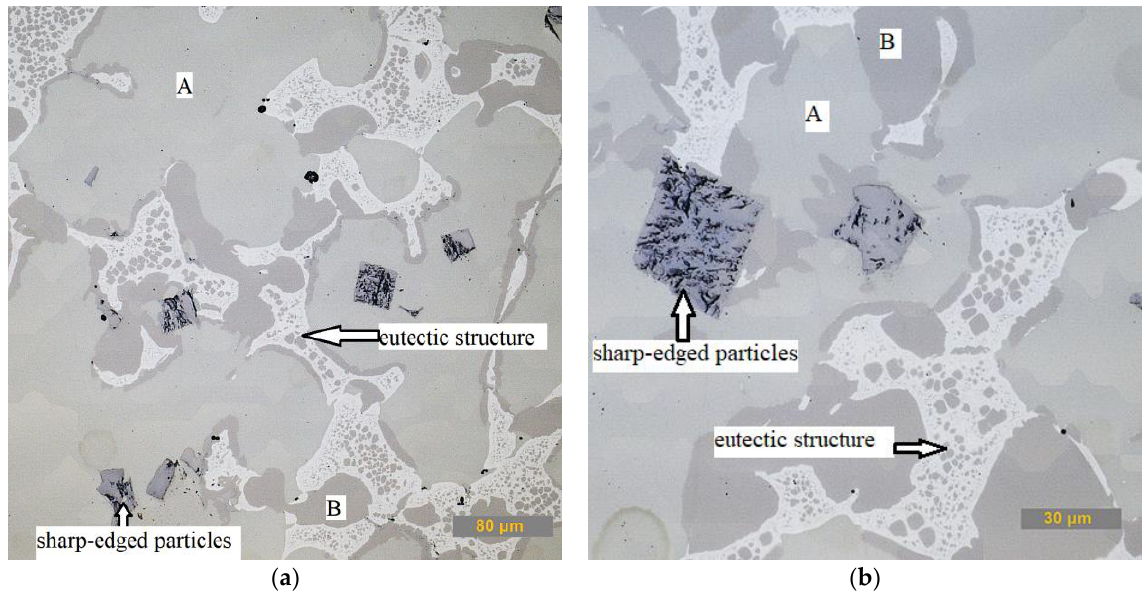
Figure 2. Microstructure of Co70W12Al15 alloy: ( a ) the overall microstructure; ( b ) detail of the microstructure with the occurrence of sharp-edged particles.